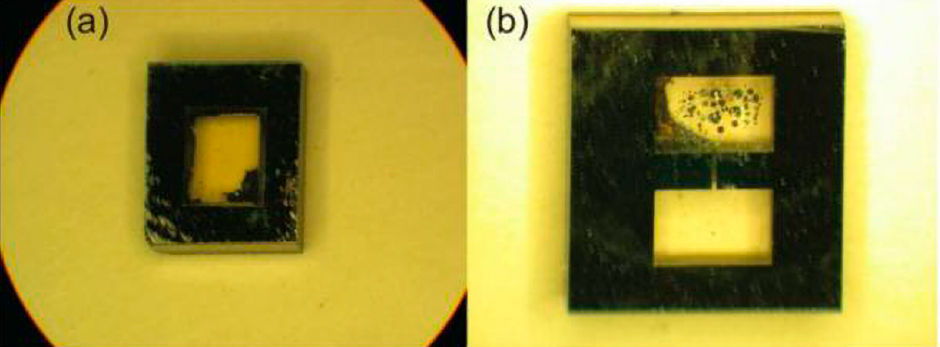
Figure 19. NIST dual-light magnetometer (2010). ( a ) A 3 × 2 × 1 mm 3 single-chamber vapor cell; ( b ) double-chamber vapor cell: two chambers with a size of 3 × 2 × 1 mm 3 connected by a 1 mm × 0.1 mm micro-channel. Reprinted from Ref [102].